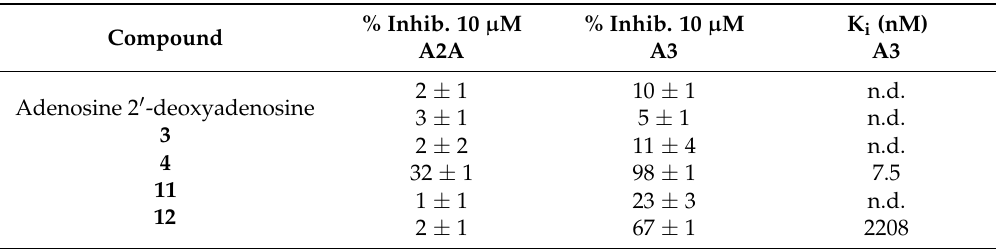
Table 1. Specific binding of the compounds 3 , 4 , and 11, 12 to adenosine receptors A2A and A3 in radioligand competition binding